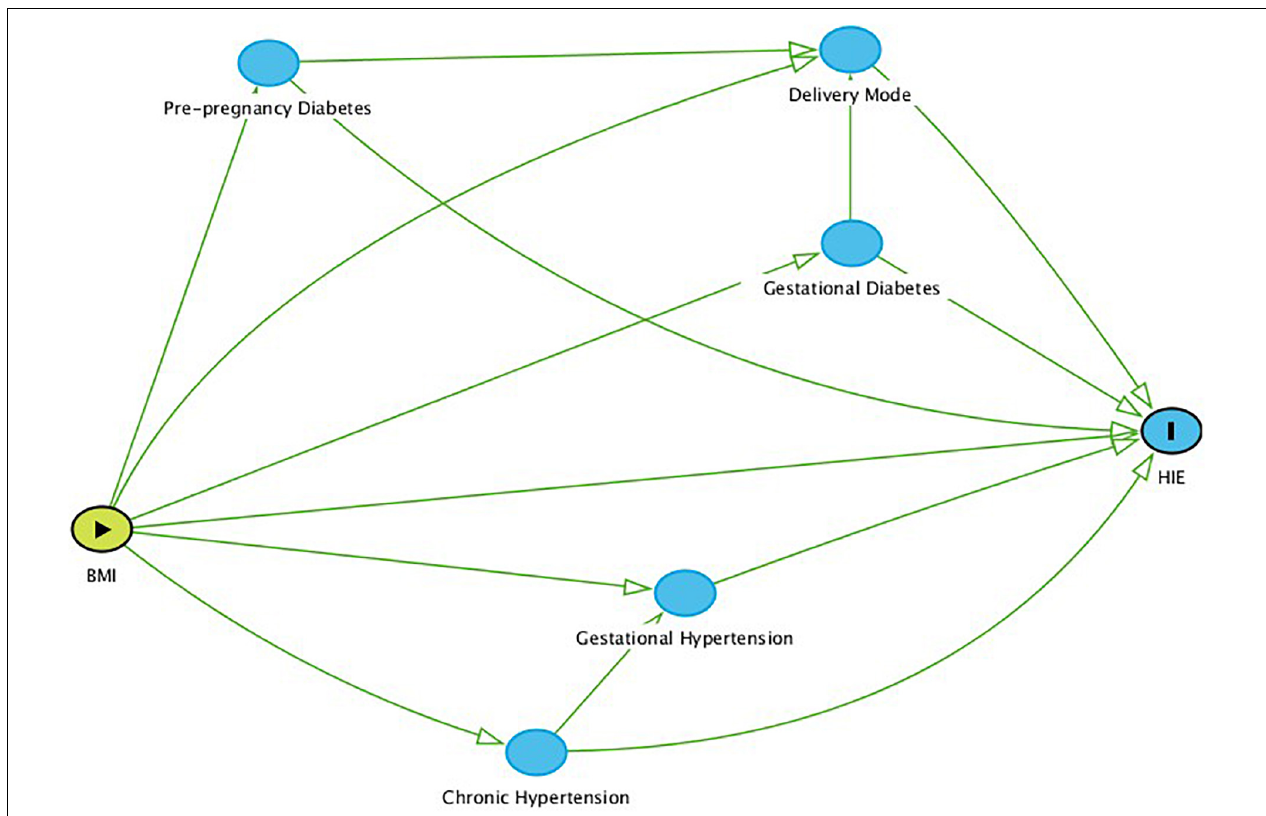
FIGURE 1 | Direct Acyclic Graph (DAG) based on known relationships between BMI, HIE, and the confounders addressed in this report. Nodes represent variables (including confounders), and arrows reflect causal